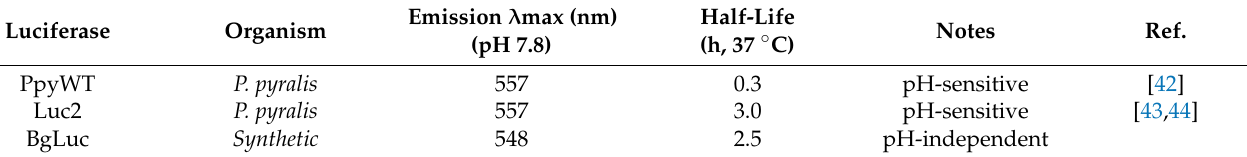
Table 1. Comparison of BL emission properties and half-life of commercial luciferases and BgLuc mutant.